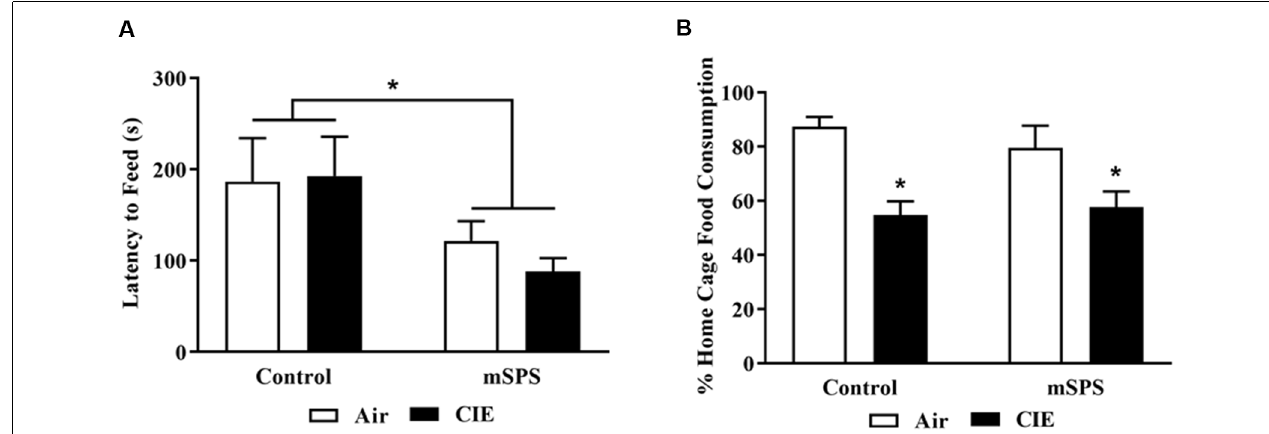
FIGURE 4 | Average of (A) latency to feed during the novelty suppressed feeding (NSF) test and (B) percent sweetened fruit cereal consumed in the home cage, after the 4th cycle of CIE (before Test 4). mSPS increased impulsivity behavior (A) , and CIE exposure decreased home cage sweetened cereal intake in mice ( n = 5–6; B) . A two-way ANOVA revealed that mSPS-exposed mice, either exposed to CIE or Air, had a shorter latency to take the first bite of a sweetened fruit cereal (* p < 0.05) compared to mSPS controls. A two-way ANOVA also revealed that CIE-exposed mice, either exposed to mSPS or Control (non-mSPS) conditions previously, consumed less sweetened cereal in their home cages compared to Air-exposed mice. Data are mean ± SEM.